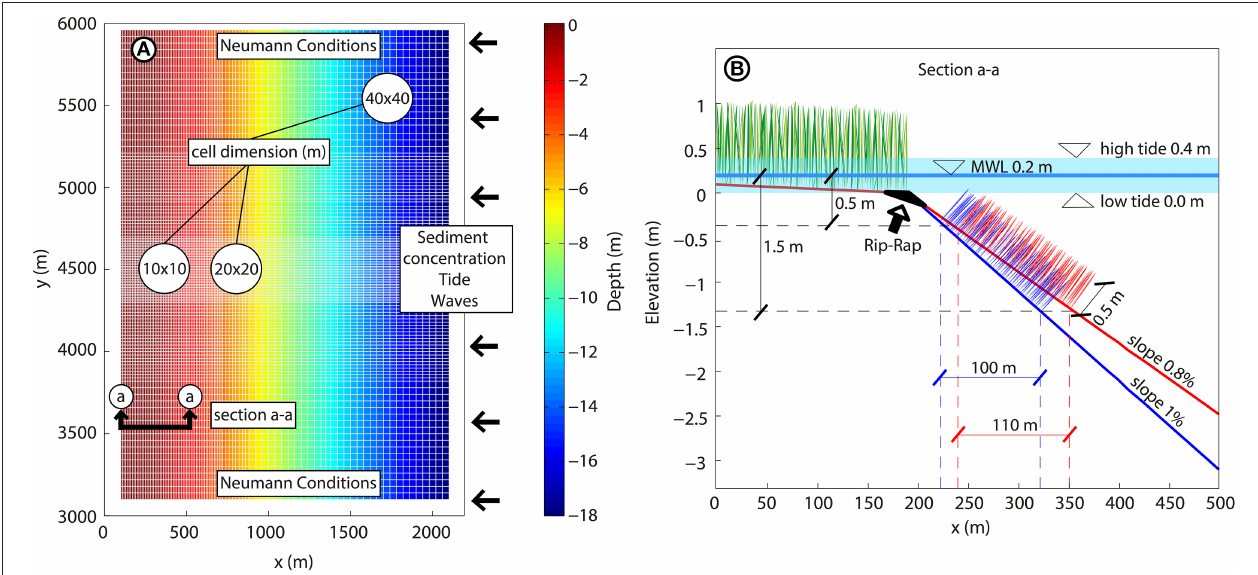
FIGURE 3 | Flow domain configuration. (A) Planimetry of the model with cell dimensions and boundary conditions on the north/south side (Neumann condition) and east side (waves, tide, and suspended-sediment concentration). (B) Longitudinal profile (section a-a) of the domain with the two different slopes (blue line red line 0.8%) and related position of the submersed aquatic vegetation (SAV) bed [placed between 0.5 and 1.5m below the mean water level (MWL), typical SAV = depth in the Chesapeake Bay]. The top and the bottom limits of the area shaded in light blue represent high and low tides, respectively, and the dark blue line in the middle corresponds to the MWL.